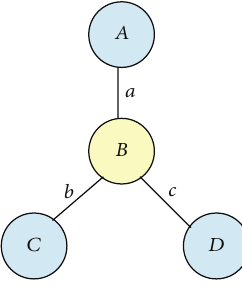
Figure 8: 𝐺 󸀠 graph of the MIS problem. Vertices 𝐴 , 𝐶 , and 𝐷 belong to the maximum independent